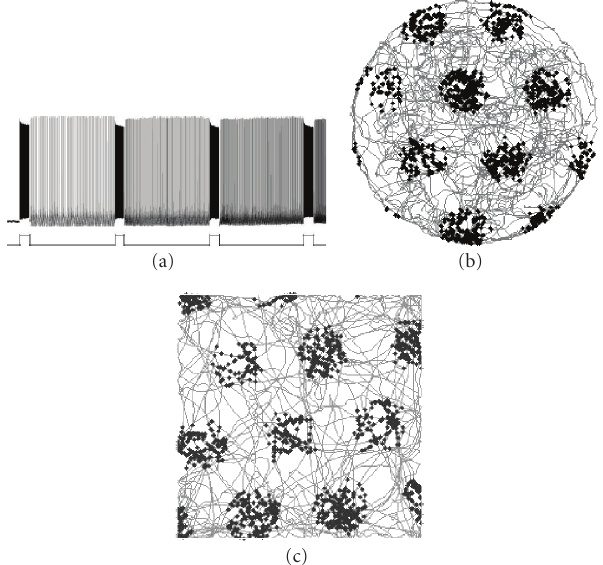
Figure 2: (a) Example of graded persistent firing in a layer V pyramidal cell from Egorov et al. [8]. (b) Simulation of grid cell firing based on persistent firing in cells from deep layers of medial entorhinal cortex. The spiking activity shown as black dots arises from convergent input from three neurons with the same baseline persistent firing frequency, with phase of input neurons influenced by input from di ff erent speed modulated head direction cells during movement (trajectory shown in gray). (c) Simulation of grid cell firing based on membrane potential oscillations in dorsal layer II stellate cells in medial entorhinal